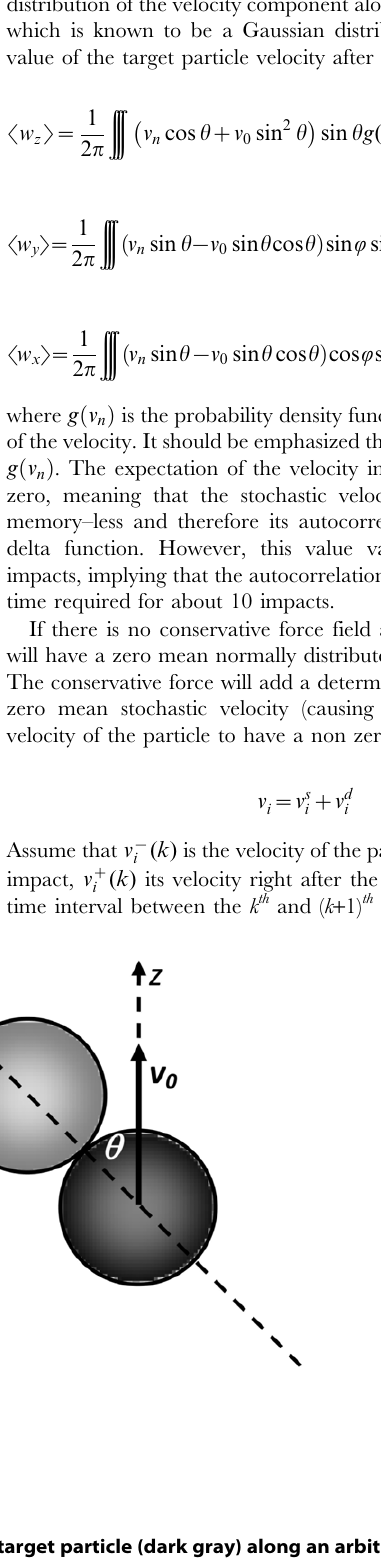
Figure 1. Collision between a colliding particle (light gray) and the target particle (dark gray) along an arbitrary direction of impact (dashed line). The colliding particle can have any velocity for an impact along any direction. Panel A shows a collision when the velocity of the colliding particle along the impact direction ( v n ) is faster than the velocity of the target particle along this direction. In panel B, the velocity of the colliding particle is slower.